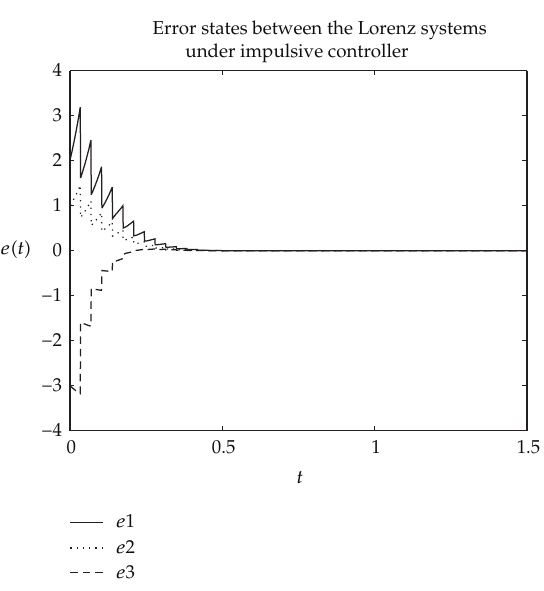
Figure 1: The trajectories of the error Lorenz system under impulsive controller with t k − t k − 1 (cid:10) 0 .